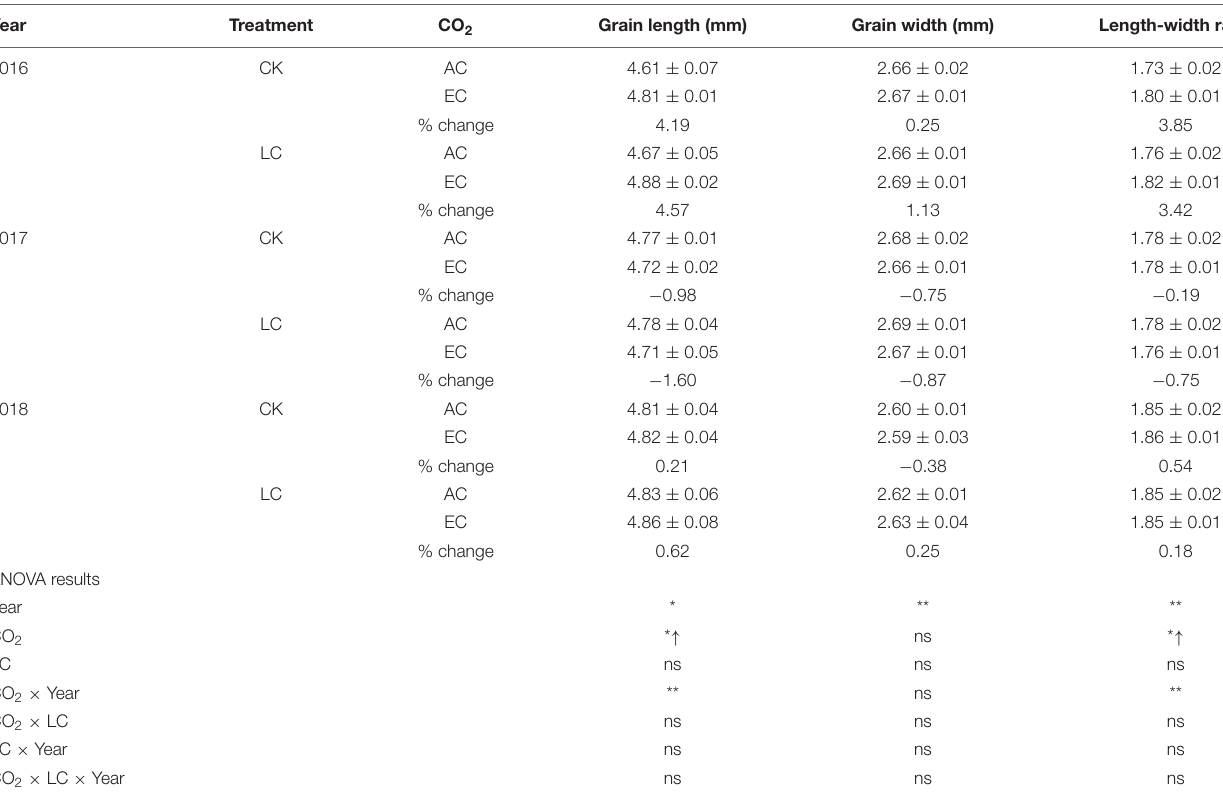
TABLE 2 | Effect of elevated CO 2 and cutting off top three leaves (LC) on grain length, grain width, length-width ratio of milled rice across three cropping seasons (2016–2018).